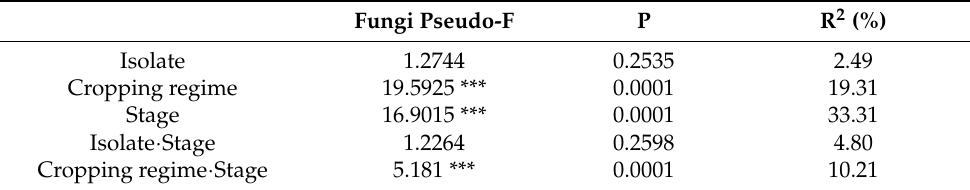
Figure 3. Temporal dynamics of diversity and distribution patterns of crop-associated microbiomes in NCC, CC, and CCi systems at BS, CD, and PD stages. ( a ) The diversity of the microbial community associated with M. sextelata as indicated by Chao1, Faith’s phylogenetic diversity, and Pielou’s evenness index. All values are indicated as the mean ± SE. The different lowercase letters indicate significant differences ( p < 0.05, Duncan); ( b ) PCoA analysis of soil microbial community associated with M. sextelata based on the Bray distance metric. The percentage value for each axis represents the proportion of total variation explained. Samples collected from NCC, CC, and CCi are shown in green, red, and blue, respectively. Circles, squares, and triangles separately represent bare soil (BS), conidial stage (CD), and primordial stage (PD), respectively; ( c ) Boxplots showing mean niche breadth in soil fungal communities. Lower letters represent p < 0.05; ( d ) Relative contributions of habitat generalists and specialists in soil fungal communities. Table 1. Results of PERMANOVA testing of the e ff ects of Cropping regime (NCC, CC, and CCi), Stage (BS, CD, and PD), and Isolate (HX13 and YN05) on fungal communities. Signi fi cant e ff ects are indicated in bold ( *** p < 0.001).